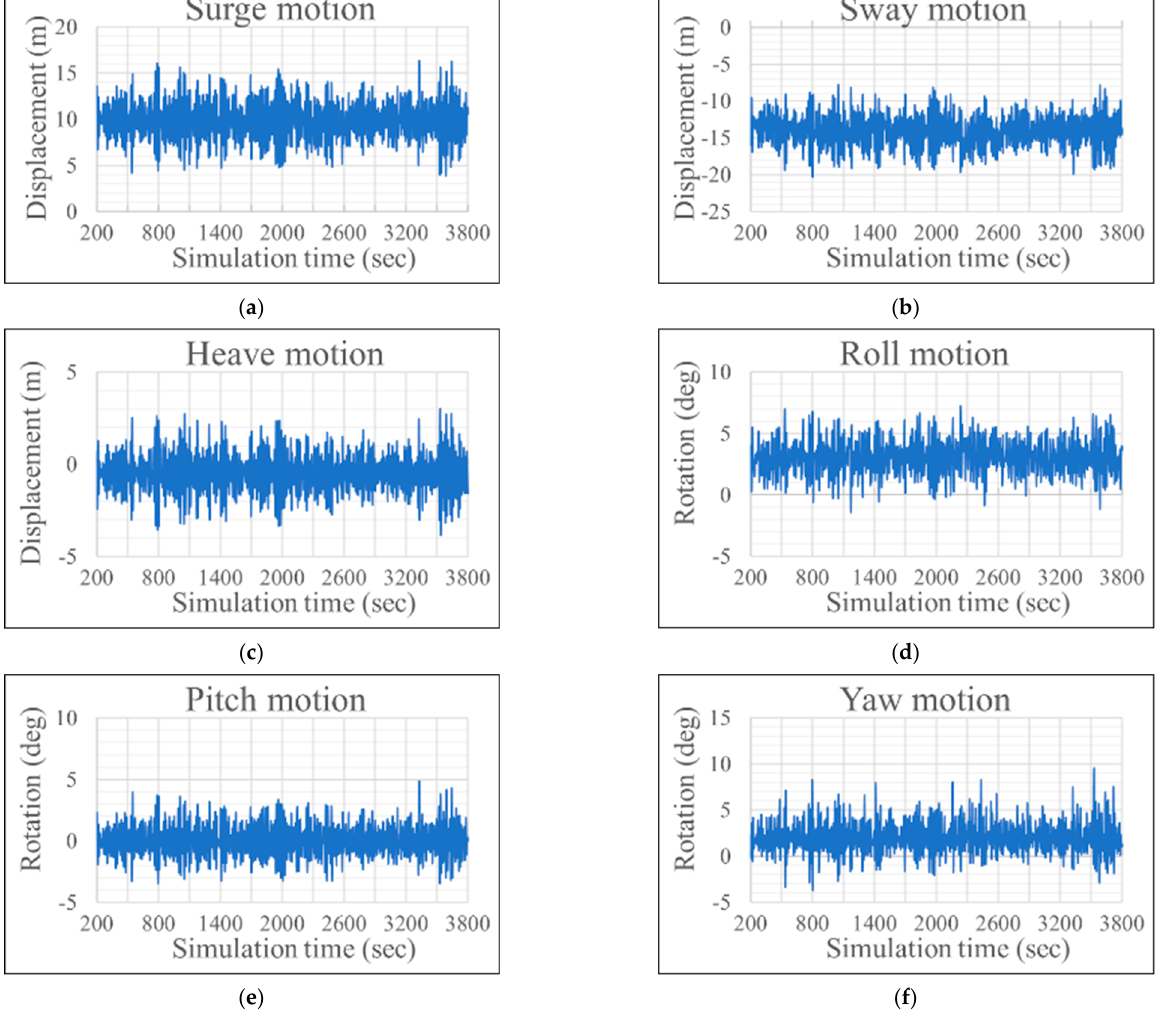
Figure 11. Six D.O.F. motion results of spar-type platform (LC06 case). ( a ) Surge motion; ( b ) Sway motion; ( c ) Heave motion; ( d ) Roll motion; ( e ) Pitch motion; ( f ) Yaw motion. Table 10. Dynamic motions of 5 MW FOTW platform.